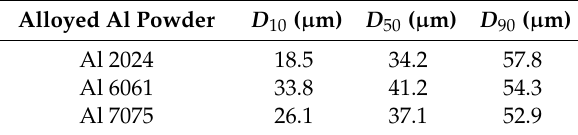
Table 1. PSD characteristics for three of the alloyed Al powders from Company B studied herein.